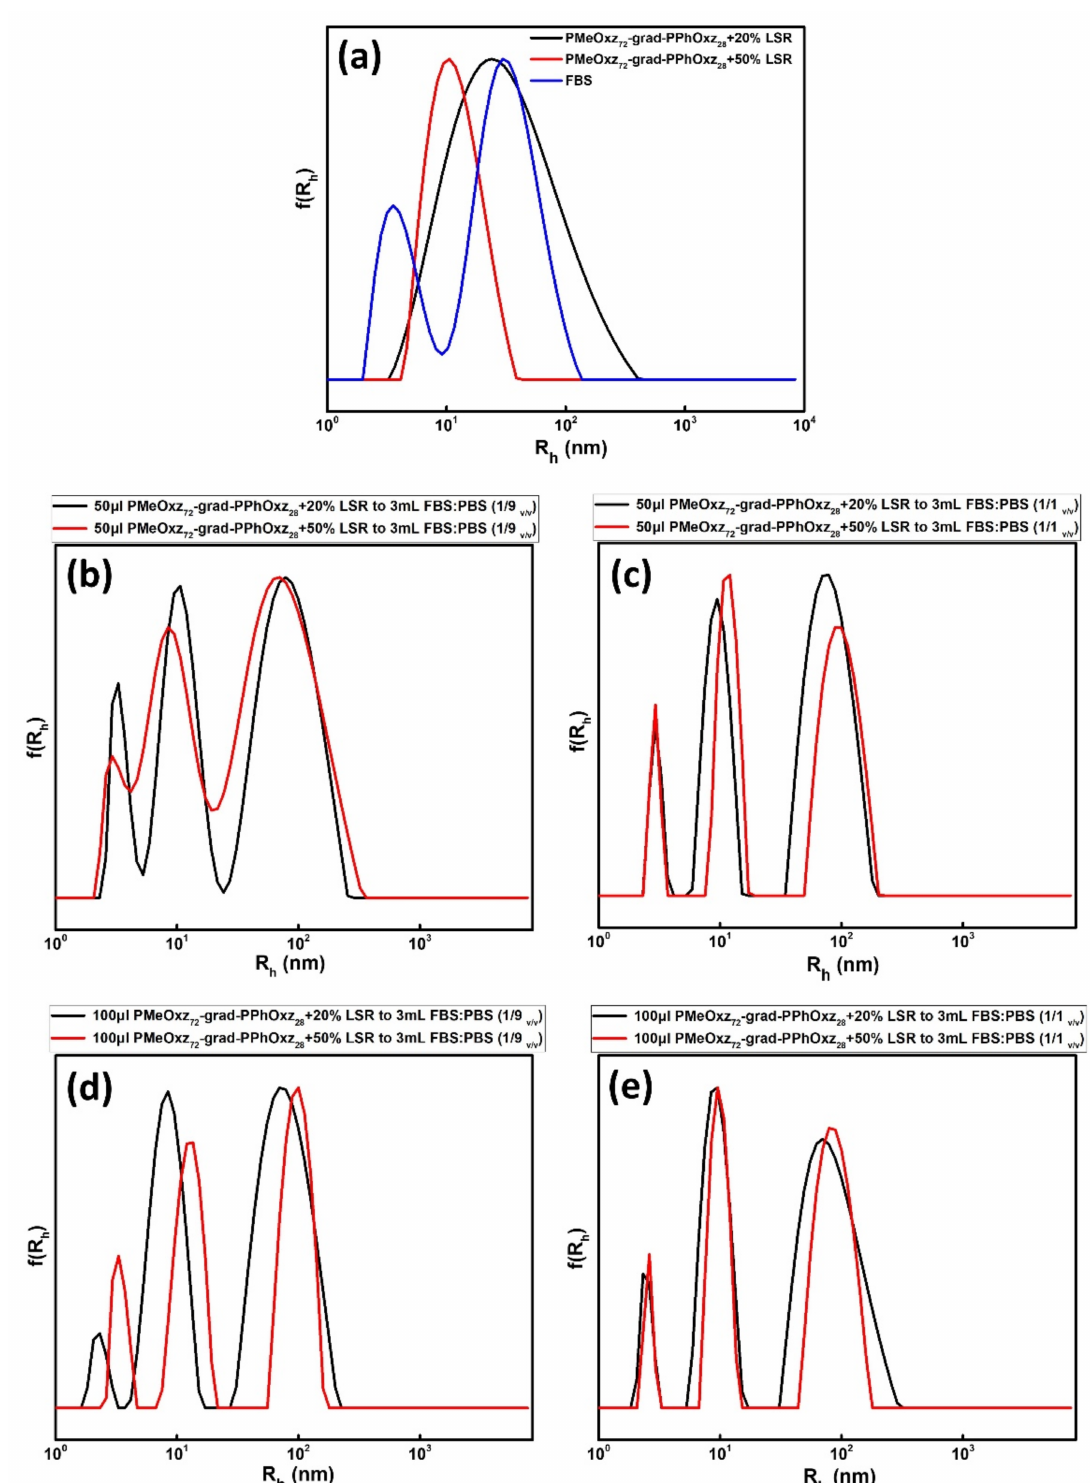
Figure 5. Comparative size distributions of ( a ) PMeOxz 72 -grad-PPhOxz 28 + 20% LSR, PMeOxz 72 -grad-PPhOxz 28 + 50% LSR nanocarriers and bear FBS, ( b ) PMeOxz 72 -grad-PPhOxz 28 + 20% LSR + FBS:PBS (1/9 v/v) and PMeOxz 72 -grad- PPhOxz 28 + 50% LSR + FBS:PBS (1/9 v/v) using protocol 1, ( c ) PMeOxz 72 -grad-PPhOxz 28 + 20% LSR + FBS:PBS (1/1 v/v) and PMeOxz 72 -grad-PPhOxz 28 + 50% LSR + FBS:PBS (1/1 v/v) using protocol 1, ( d ) PMeOxz 72 -grad-PPhOxz 28 + 20% LSR + FBS:PBS (1/9 v/v) and PMeOxz 72 -grad-PPhOxz 28 + 50% LSR+FBS:PBS (1/9 v/v) using protocol 2, ( e ) PMeOxz 72 - grad-PPhOxz 28 + 20% LSR+FBS:PBS (1/1 v/v) and PMeOxz 72 -grad-PPhOxz 28 + 50% LSR + FBS:PBS (1/1 v/v) using protocol